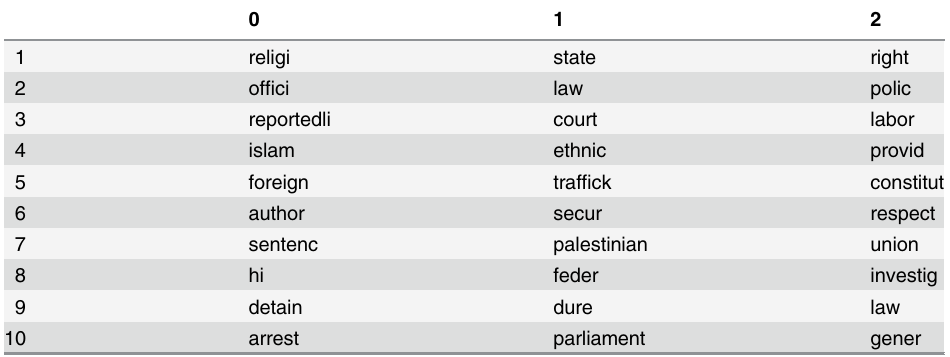
Table 13. Ten most important words for the CIRI Freedom of Religion variable.